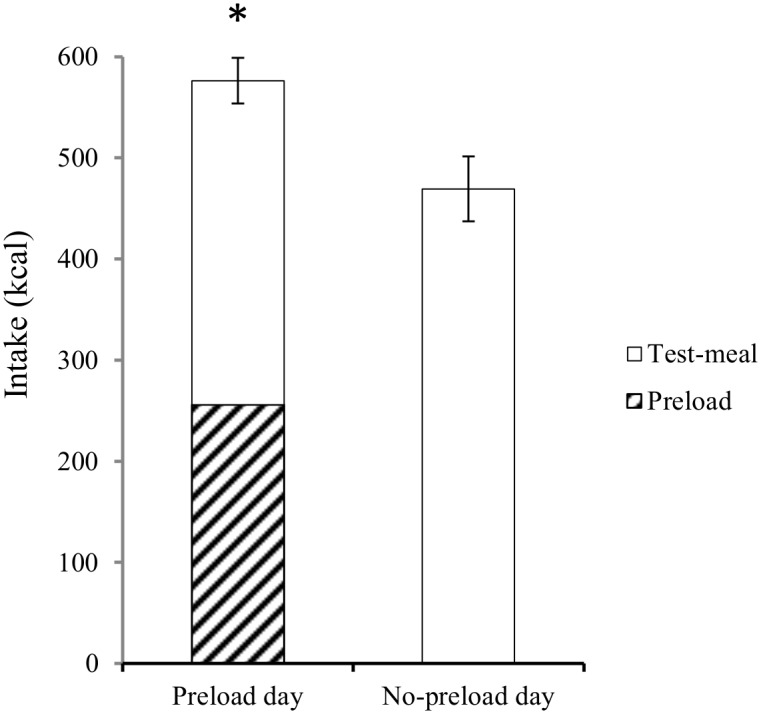
Mean total intake (kcal) on the pizza preload and no-preload test days.Errors bars represent ± 1 SE from the mean. * Total intake (preload + test-meal) significantly higher on preload day relative to no-preload day, p <.001.